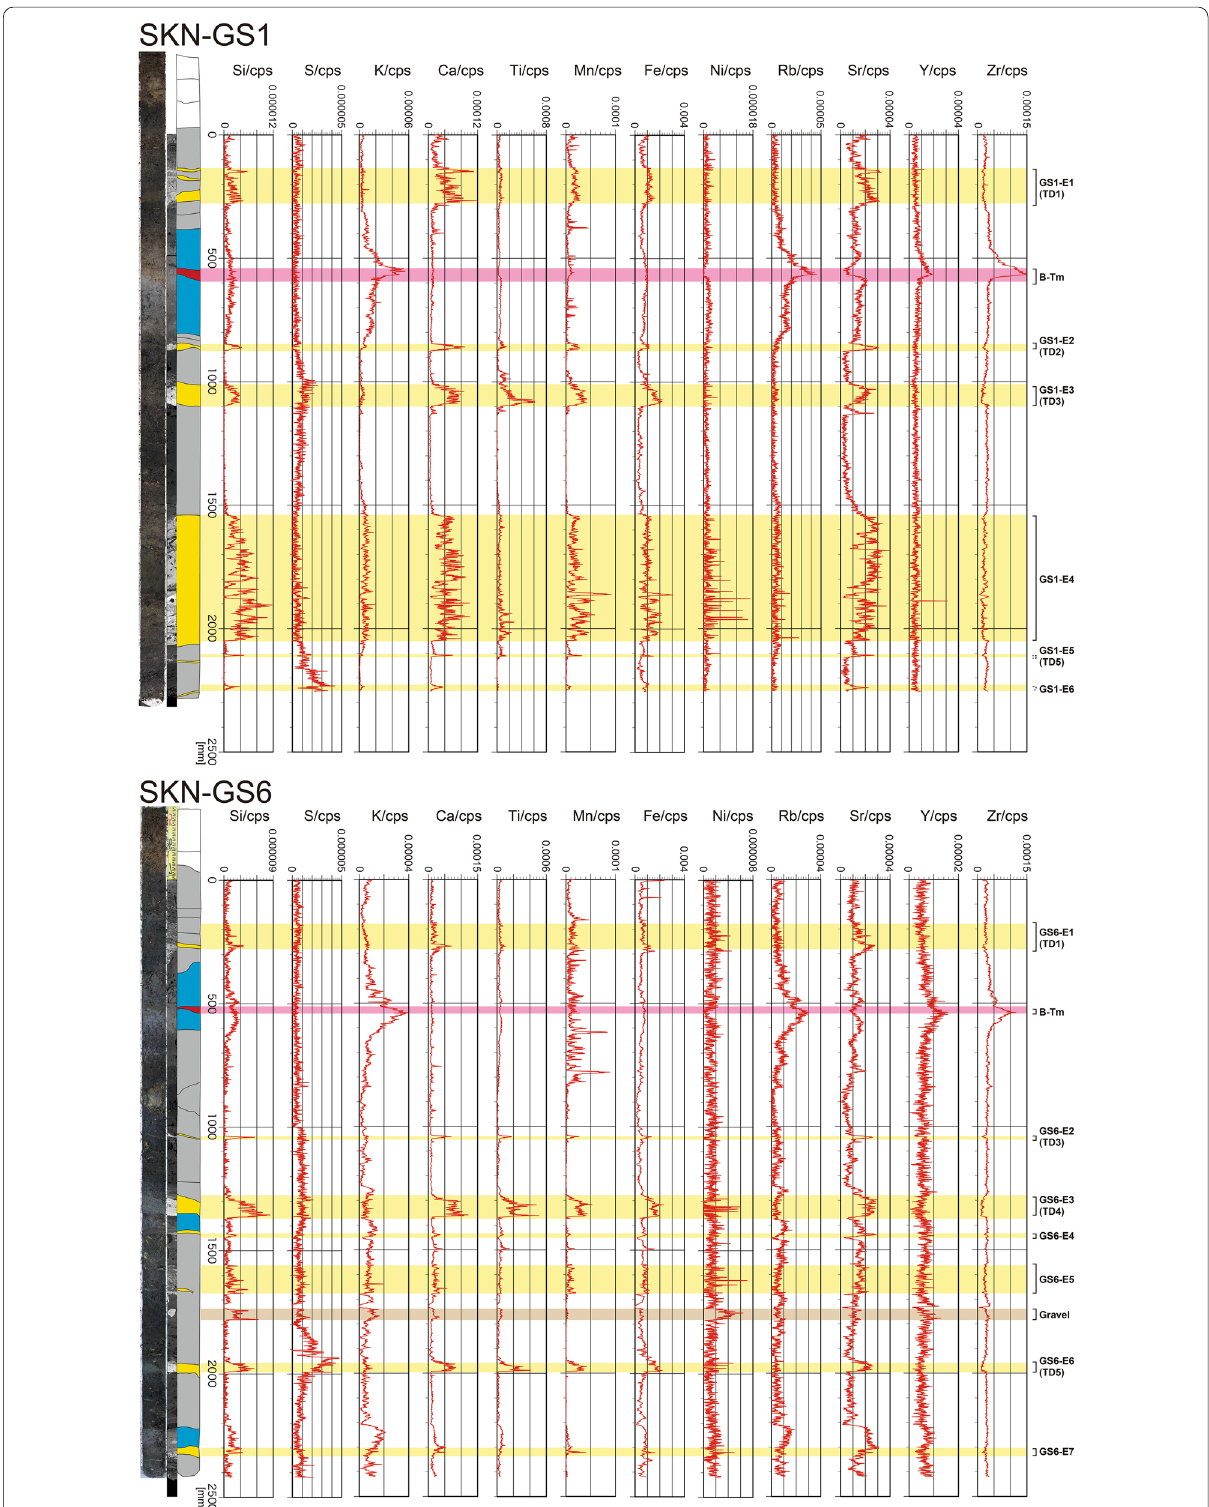
Fig. 8 Results of the ITRAX micro-X-ray-fluorescence core scanning of SKN-GS1 and SKN-GS6. Each elemental datum was normalized by counts per second